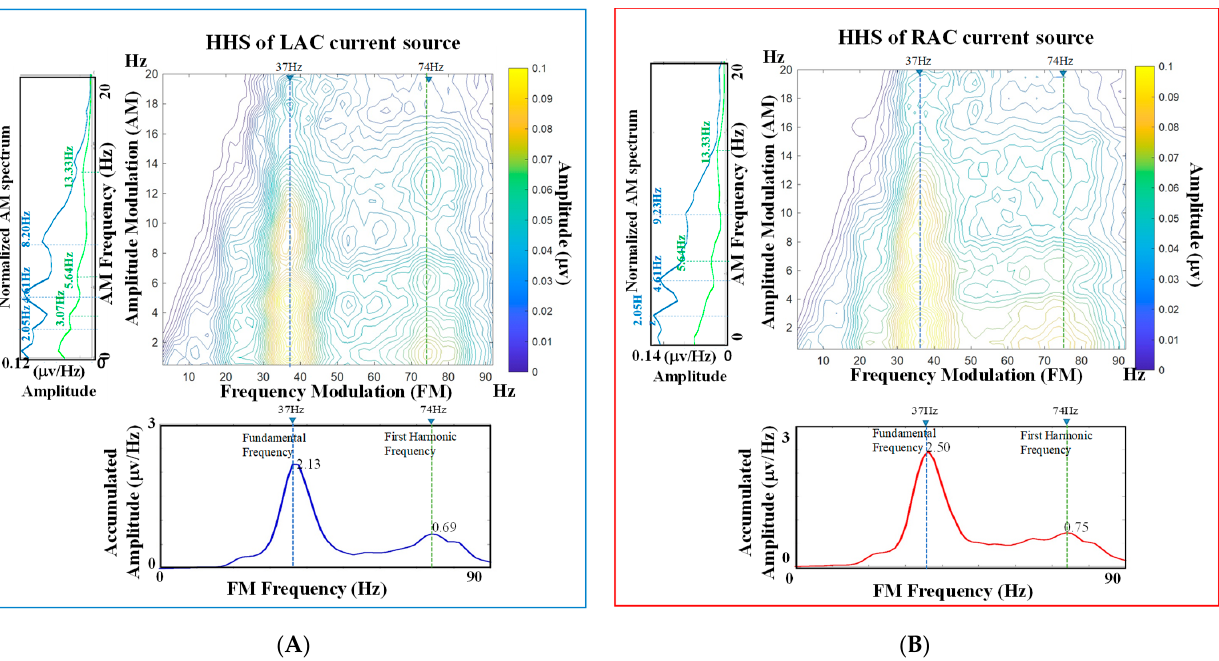
Figure 3. The HHS plots of the source activities in auditory cortexes: ( A ) The HHS plot of the source activities in LAC. The lower panel shows the FM spectrum, and the left panel shows the AM spectrum. ( B ) The HHS plot of the source activities in RAC. The lower panel shows the FM spectrum, and the left panel shows the AM spectrum.